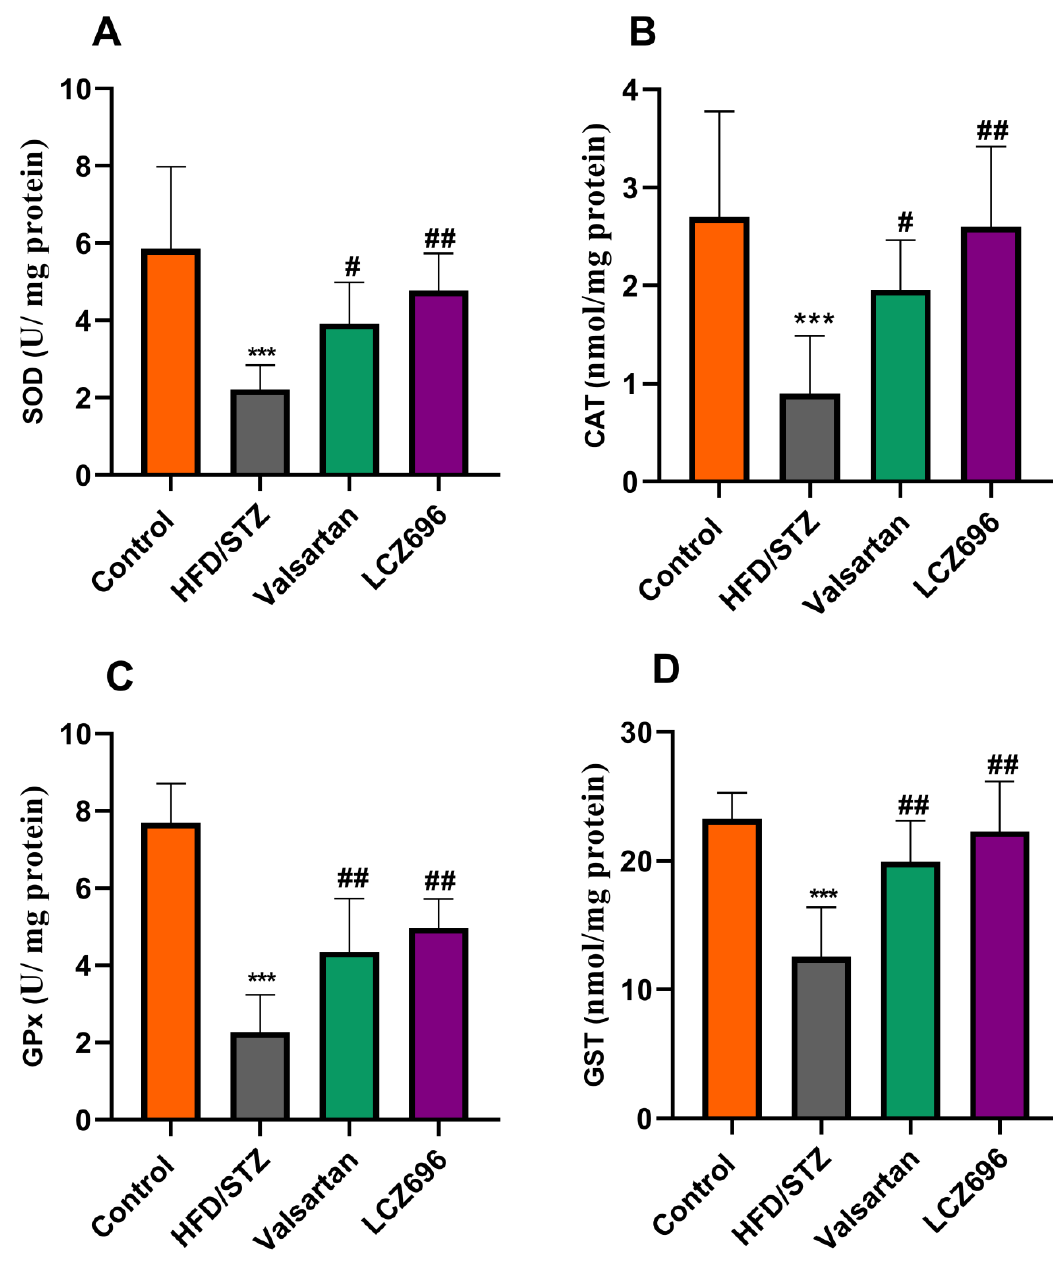
Figure 4. The impact of LCZ696 and valsartan treatment on the renal antioxidant status of HFD/STZ-induced diabetic rats, including superoxide dismutase (SOD) levels ( A ), catalase (CAT) activity ( B ), glutathione peroxidase (GPx) ( C ), and glutathione-S-transferase (GST) ( D ). The data are expressed as the mean ± SEM, n = 6, *** p < 0.001 versus control; # p < 0.05, ## p < 0.01 versus HFD/STZ.